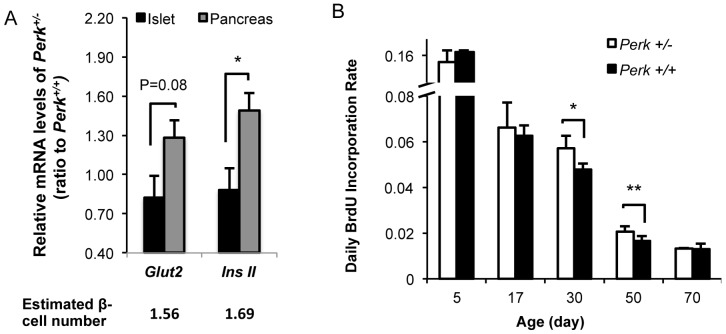
P50 Perk+/− mice exhibit higher β-cell number due to elevated β-cell proliferation.A. Gene expression levels of islets or whole pancreata from P50 Perk+/− mice relative to Perk+/+ control. Shown are means ± SEM. Below the bar graph shows the estimated fold-increase of β-cell number of P50 Perk+/− mice relative to Perk+/+ control using each β-cell specific gene (islet data: n = 3, 4; pancreas data: n = 6, 4. *P<0.05). B. Daily BrdU incorporation rate of β-cells in mice at various ages. Shown are means ± SEM (n for Perk +/−, Perk+/+  =  5, 5 (P5); 3, 4 (P17); 10, 10 (P30); 4, 4 (P50); 3, 3 (P70). *P<0.05).